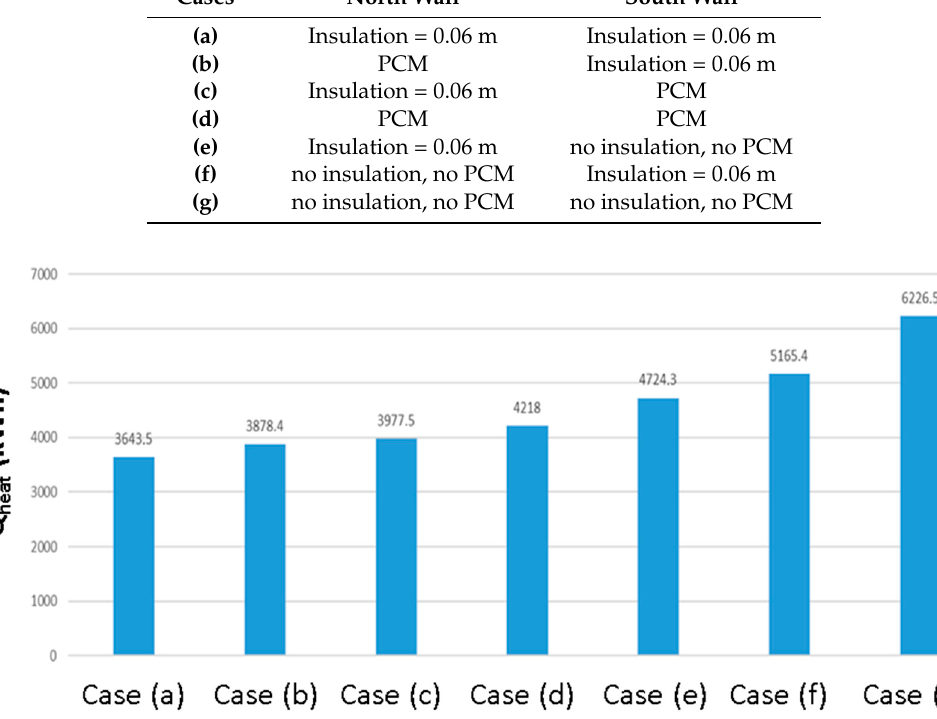
Figure 4. Annual heating loads for the examined cases.